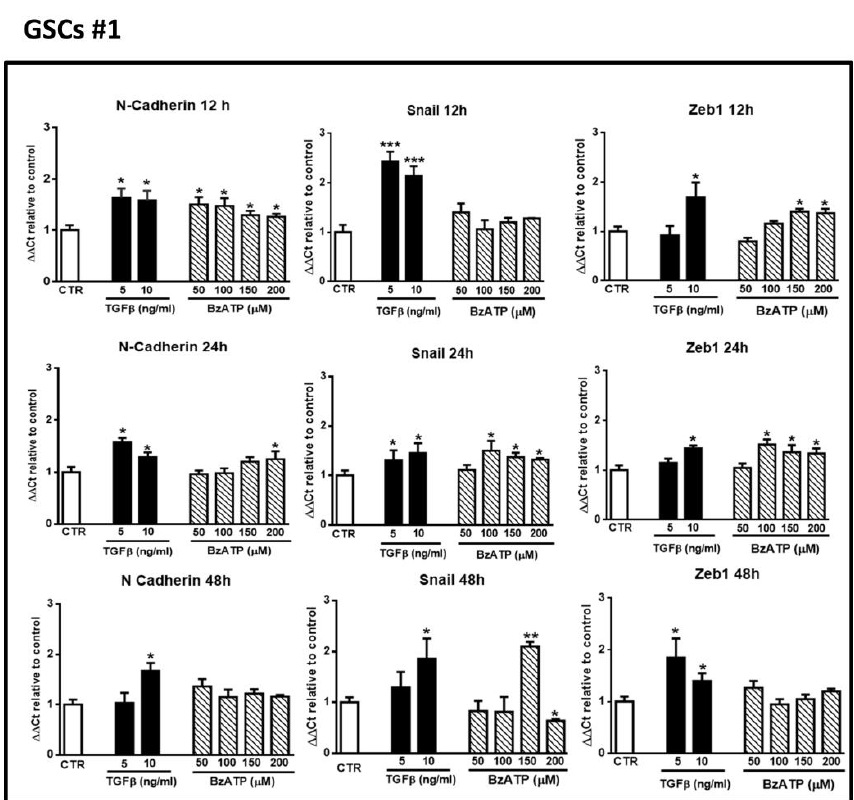
Figure 2. E ff ect of Transforming Growth Factor β 1 (TGF β 1) or 2’(3’)- O -(4-benzoylbenzoyl)-ATP (BzATP) on EMT markers evaluated by qRT-PCR at di ff erent times after drug administration to cultured GSCs #1. GSCs, grown up to their confluence in vitro, were exposed to di ff erent concentrations of TGF β 1 or BzATP. At the indicated time points cells were collected to obtain their mRNA to analyze the gene expression of the indicated EMT markers. mRNA levels were normalized ( ∆ Ct) by using the house keeping GAPDH as endogenous control and the results were analyzed for relative quantitation among groups using the comparative 2 ∆∆ Ct method. Values, calculated as fold of increase vs. untreated cells assumed as control (CTR) are the mean ± S.E.M. of three independent experiments, in which each sample was tested in duplicate. * p < 0.05, ** p < 0.01, *** p < 0.001: statistical significance vs. CTR (one-way ANOVA plus Dunnett’s test).